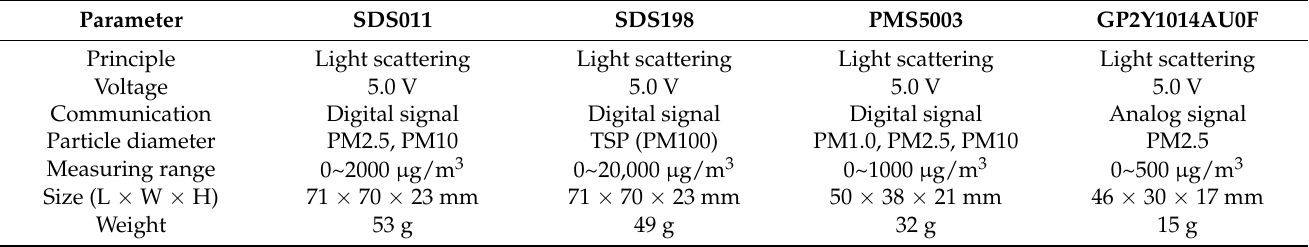
Table 2. Major specifications of four common PM